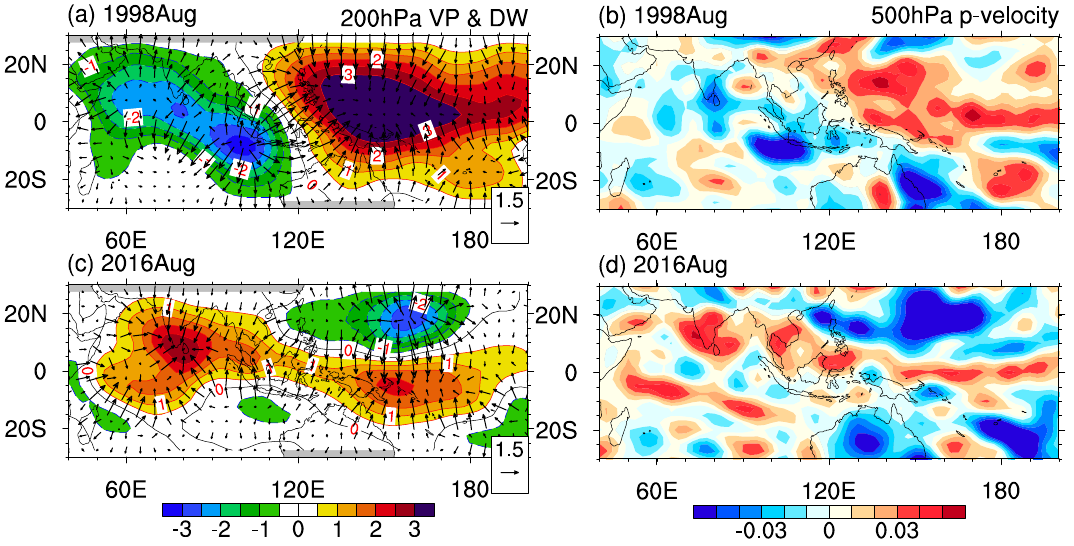
Figure 8. ( a ) The 200-hPa velocity potential anomalies (shading, units: 10 − 6 m 2 / s) and divergent wind anomalies (vectors, units: m / s) in August 1998. ( b ) The 500-hPa vertical pressure velocity anomalies in August 1998 (shading, units: Pa / s). ( c )–( d ) Same as in ( a )–( b ) but for the results in August 2016.